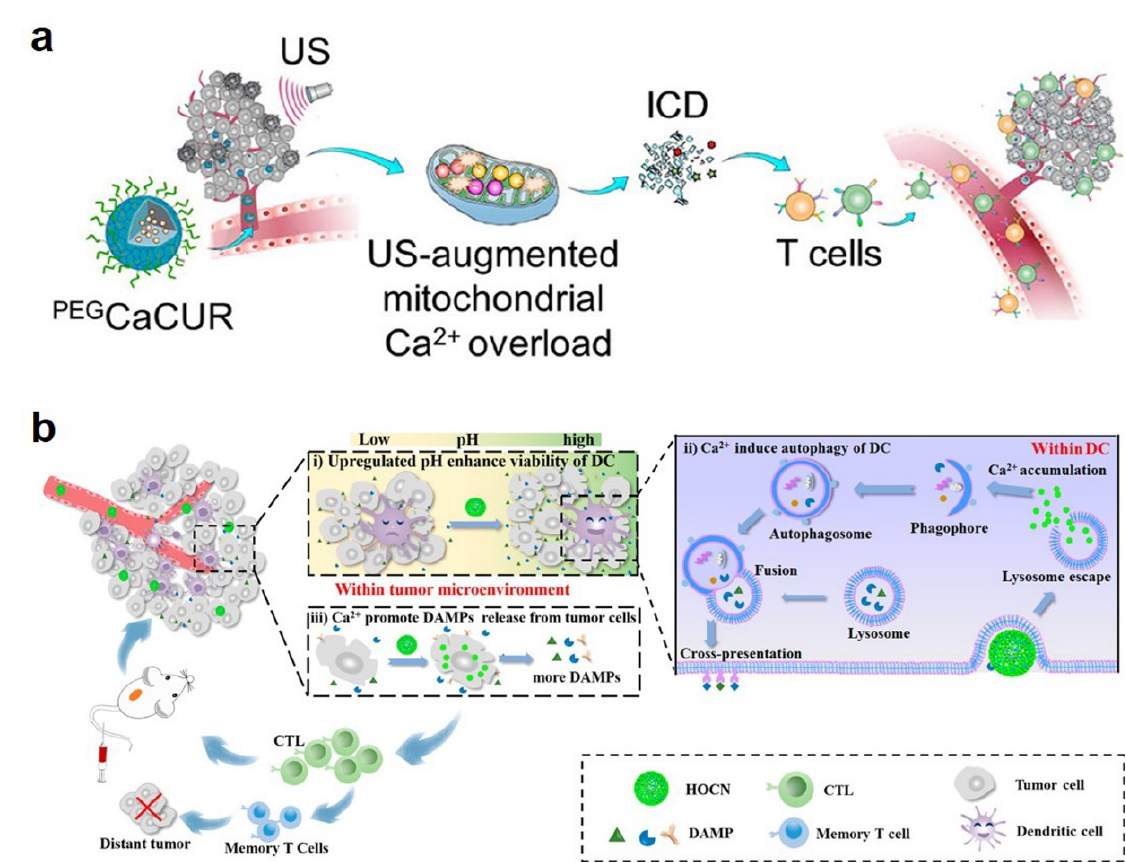
Figure 5. ( a ) Schematic illustration of PEG CaCUR NPs-based immunotherapy. Reprinted with per-